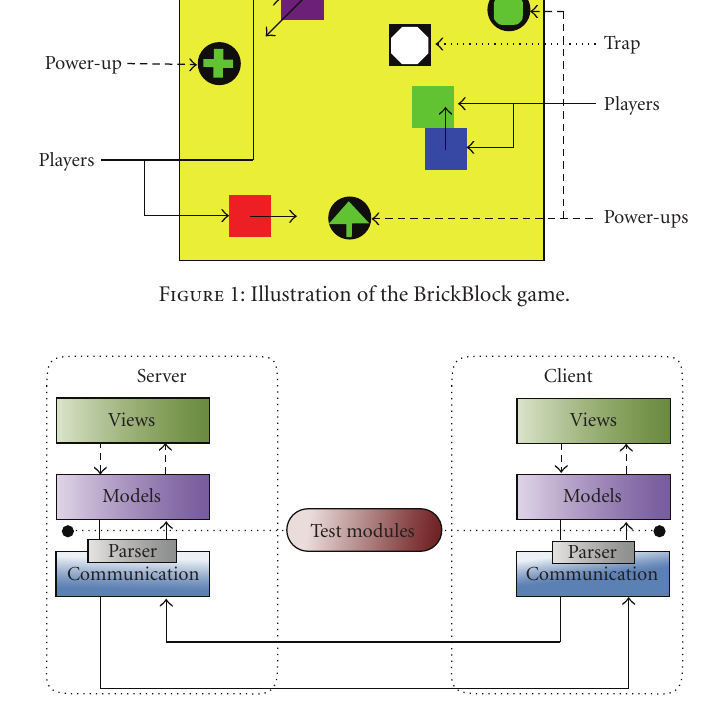
Figure 2: Architectural overview of BrickBlock.